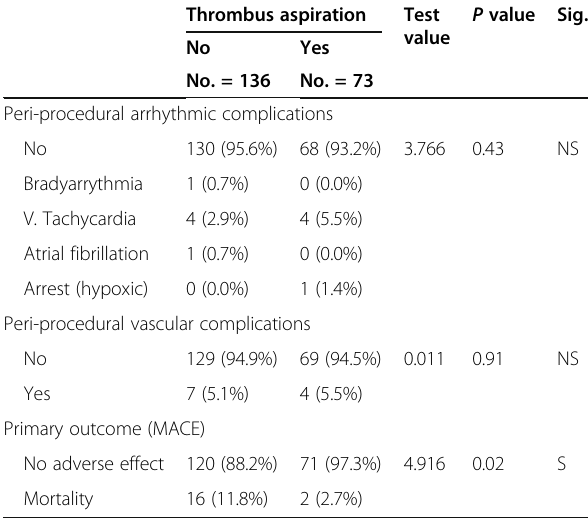
Table 4 Mortality was significantly lower in the thrombus aspiration group that had occurred in 2.7% of group (B), but in 11.8% of group (A). There was non-significant difference between the two groups as regard other complication (stroke, non-fatal MI, and target vessel revascularization) P value Thrombus aspiration Test value